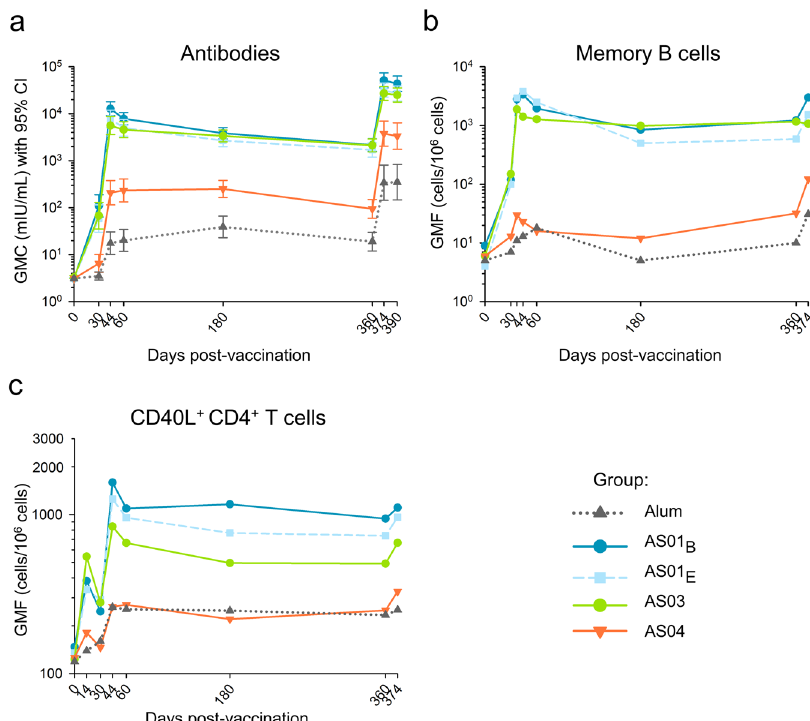
Fig. 1 Persistence and post-antigen recall responses of HBsAg-speci fi c antibodies, memory B cells, and CD4 + T cells in the Booster Cohort. Subjects of the per-protocol Booster Cohort ( N = 265) received two doses of hepatitis B surface antigen (HBsAg) vaccine adjuvanted with AS01 B , AS01 E , AS03, AS04, or Alum at Day (D)0 and D30. They also received revaccination with non-adjuvanted HBsAg, using 1/4th of the adjuvanted antigen dose, at D360. Lines and symbols are color-coded according to the adjuvant groups presented in the key. Presented are the kinetics of geometric mean concentrations (GMC) of anti-HBsAg antibodies with 95% con fi dence intervals (CI; a ), and the kinetics of geometric mean frequencies (GMF) of HBsAg-speci fi c IgG-secreting memory B cells ( b ) or CD40L + CD4 + T cells ( c